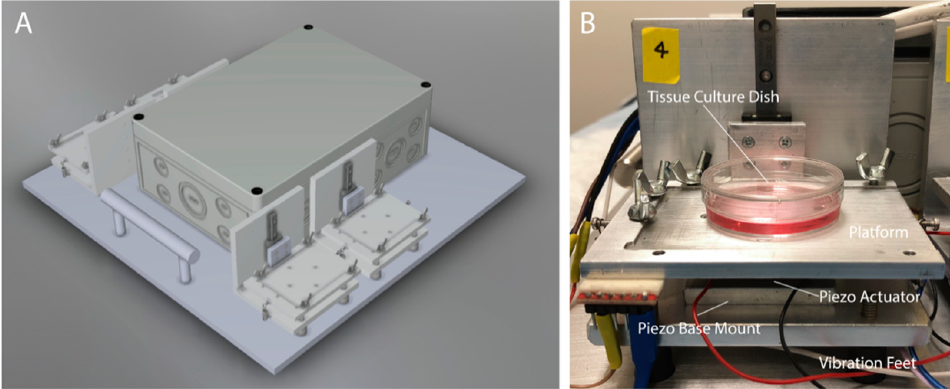
Figure 1. The custom LMHF vibration system. ( A ) Overview of the vibration system. ( B ) Description of the components in the vibration platform. Size = 85 mm × 76 mm × 94 mm.